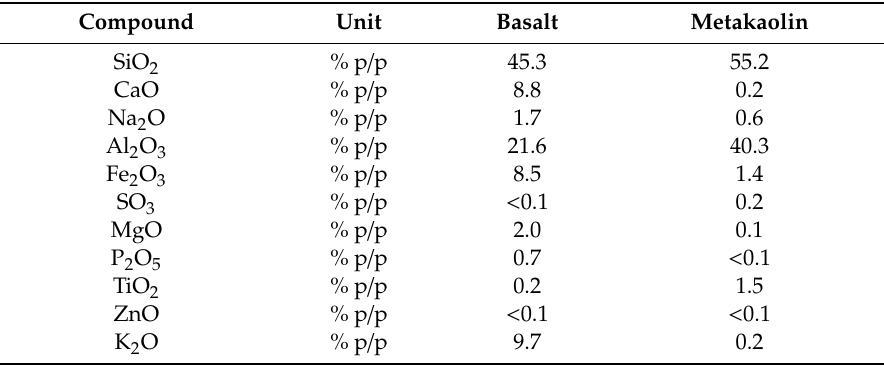
Table 1. Chemical properties of basalt and